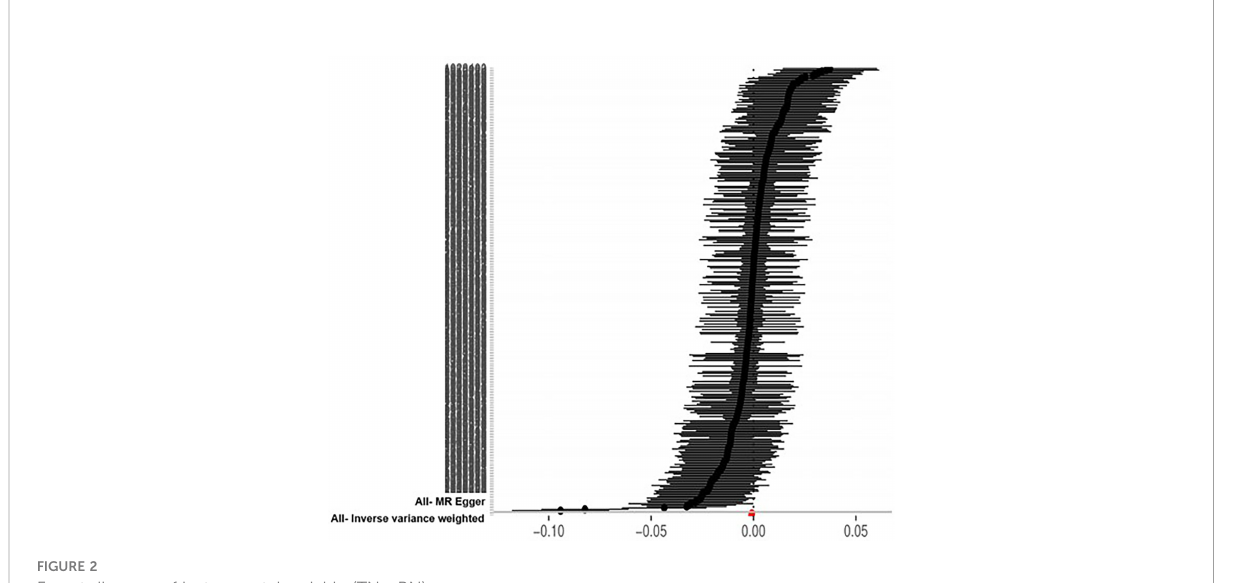
FIGURE 2 Forest diagram of instrumental variable (TN !